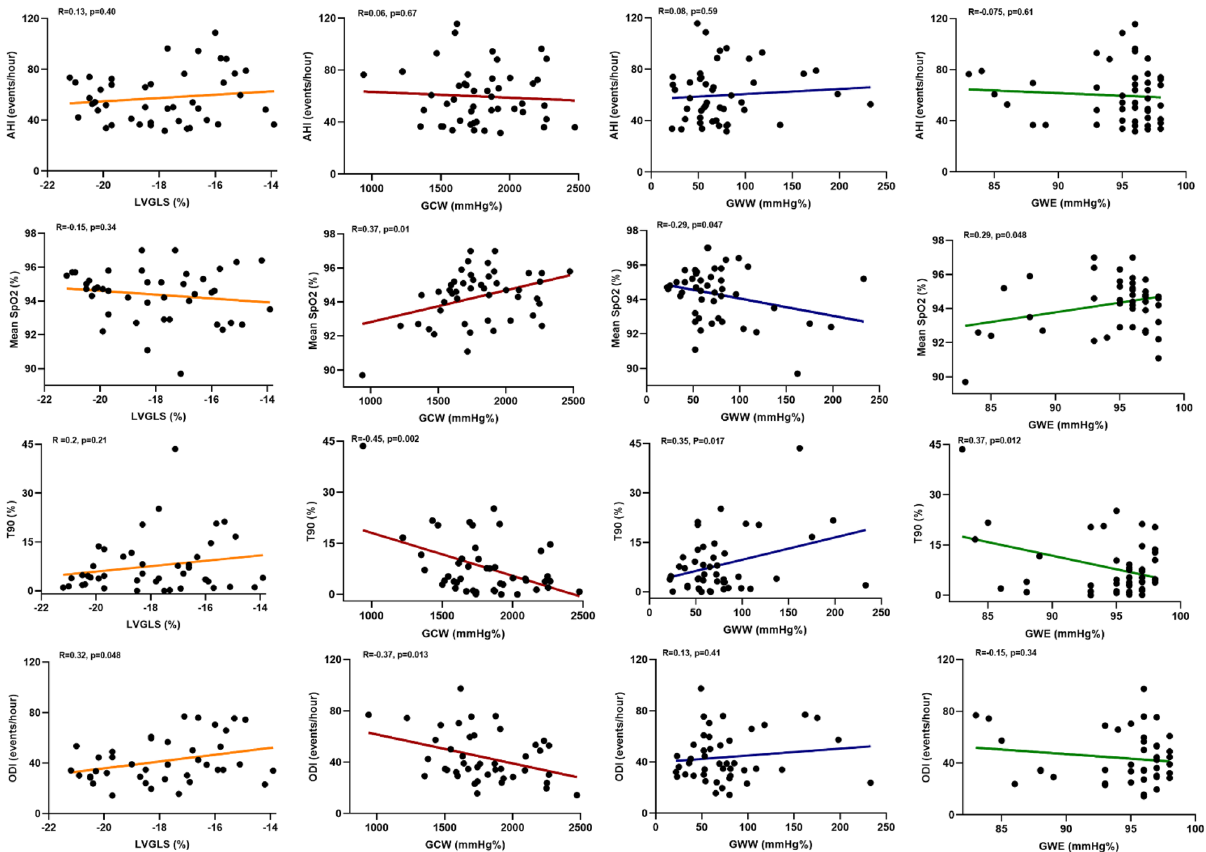
Figure 1. The correlation between AHI and hypoxemia indices (T90, mean SpO 2 , and ODI) with LVGLS and myocardial work. AHI, apnea/hypopnea index; LVGLS, left ventricular global longitudinal strain; GCW, global constructive work; GWE, global work efficiency; and GWW, global wasted work; Mean SpO 2 , mean oxygen saturation; ODI, oxygen desaturation index; T90, percentage of sleep time below 90% oxygen saturation.